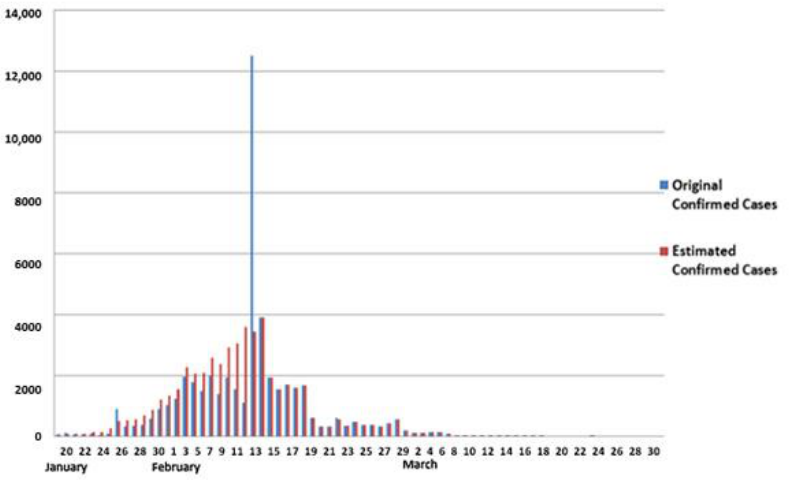
Figure 10. Original confirmed cases and estimated confirmed cases in Wuhan.